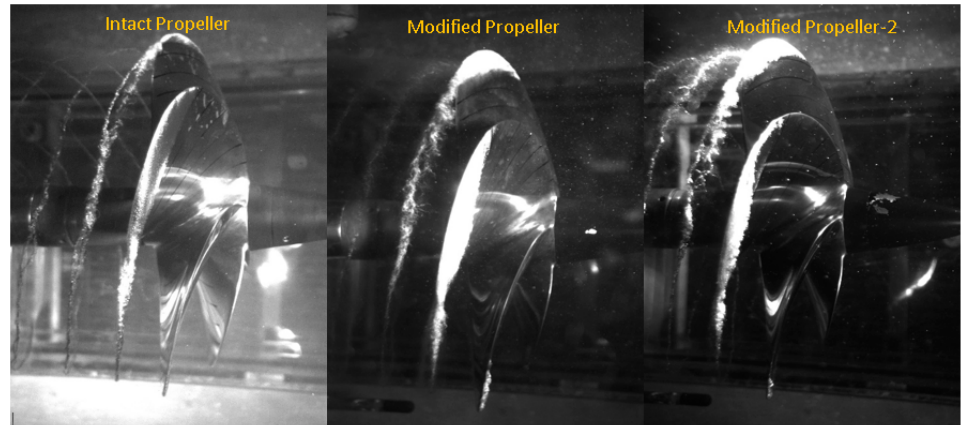
Figure 14. Intact vs. Modified propeller and Modified Propeller-2 in condition V2 and viewed from starboard. Table 4. Cavitation observation for the intact propeller, Modified Propeller and Modified Propeller-2 cases for Condition V1 and V2.